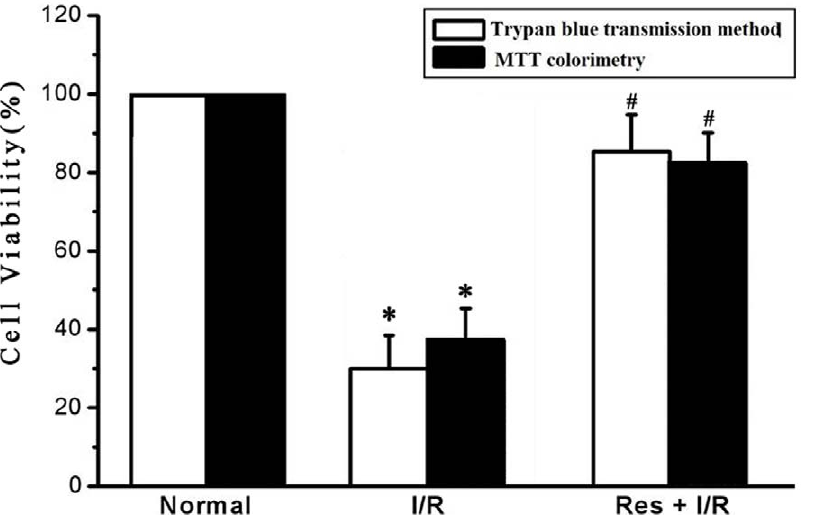
Figure 1. Effect of Res on cell viability by trypan blue method and methyl thiazolyl tetrazolium (MTT) colorimetry. The two methods revealed that Res stabilized cell membrane and increase cell viability during I/R. Res, resveratrol; I/R, ischemia/reperfusion. * P , 0.01 versus normal group, # P , 0.01 versus I/R group. Values are the means 6 SD, n=10 in each group.